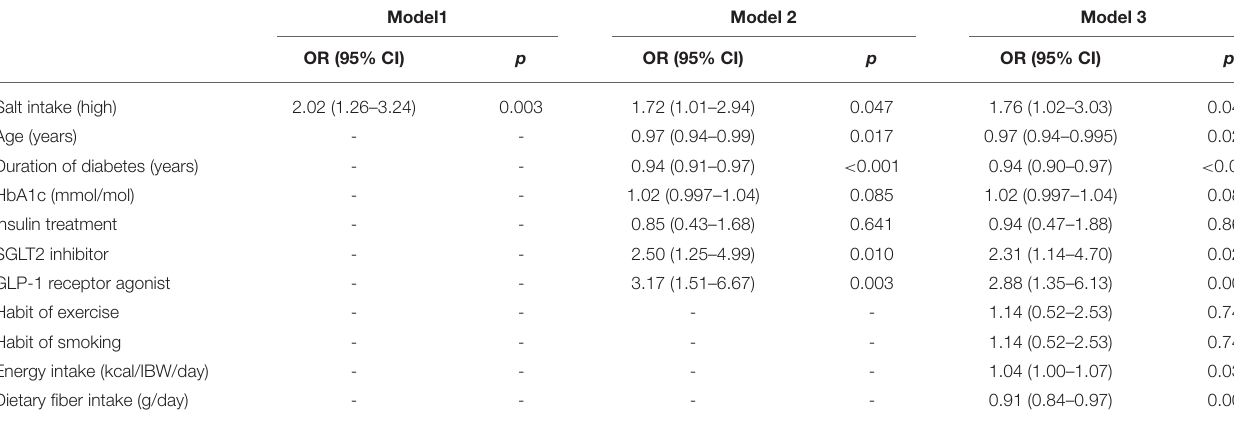
TABLE 3 | Odds ratio of salt intake on the presence of